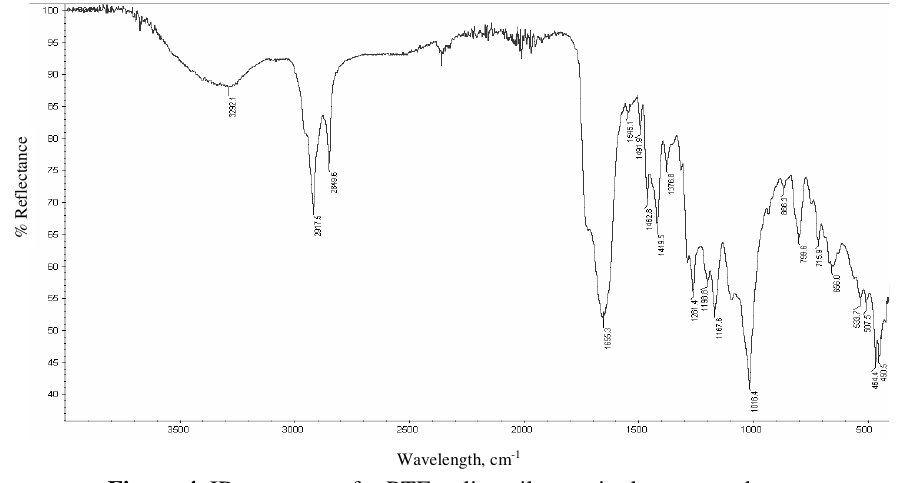
Figure 4. IR spectrum of o -PTF - olive oil -co- vinyl acetate polyester